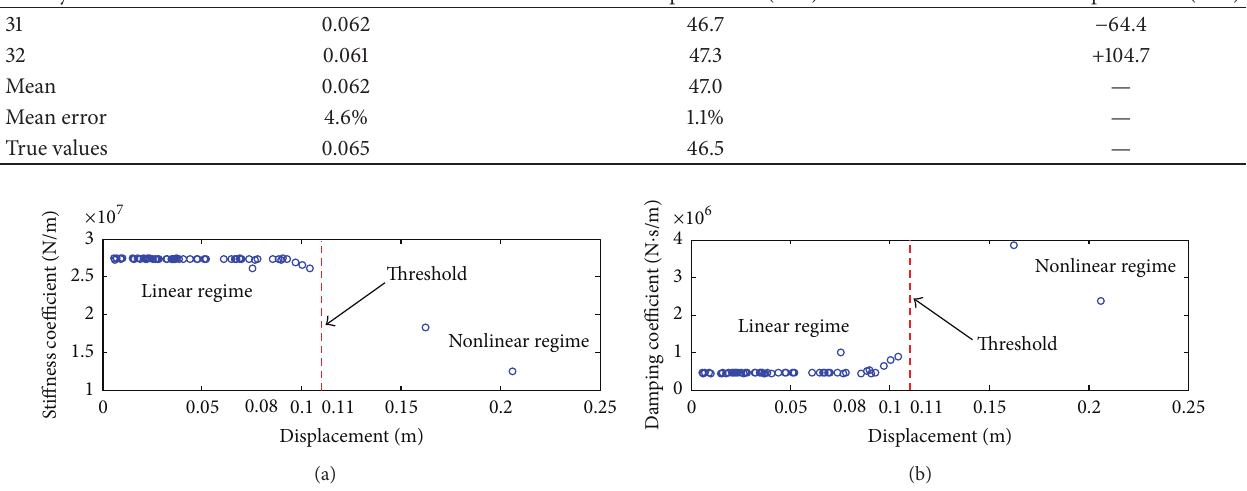
Figure 3: Linear regression results: (a) effective stiffness with half-cycle displacement; (b) effective viscous damping with half-cycle displacement.